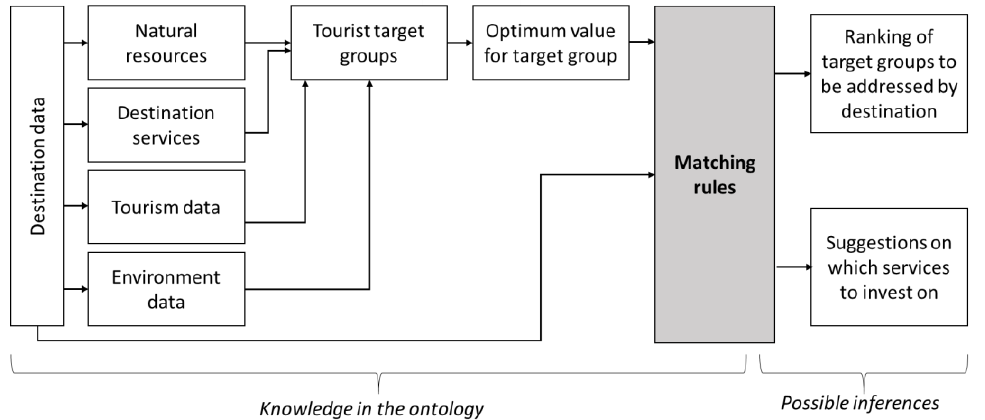
Figure 6. A schema illustrating the domains involved in Case 3 ontology and a list of outputs expected to be generated through reasoning processes.